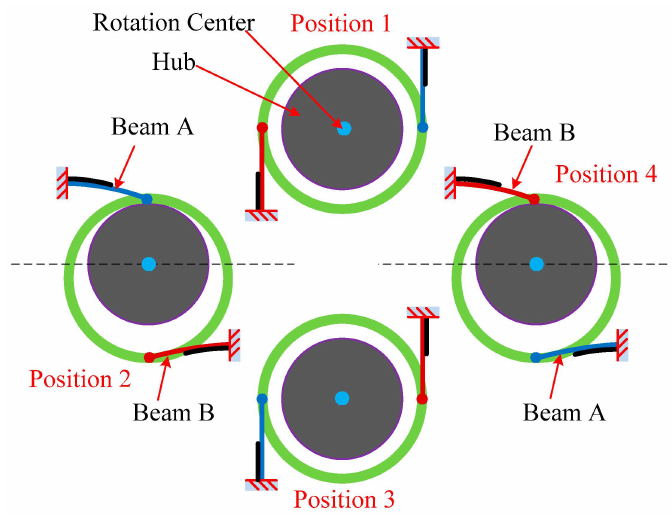
Figure 4. Schematic diagram showing four beam